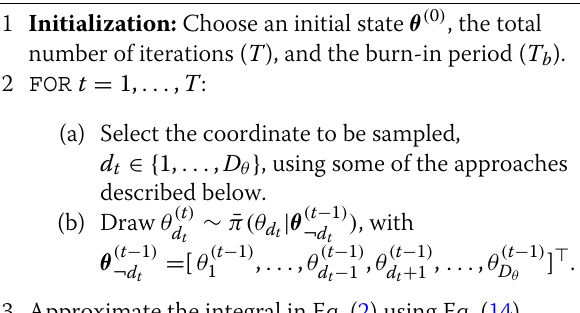
Algorithm 4 Generic Gibbs